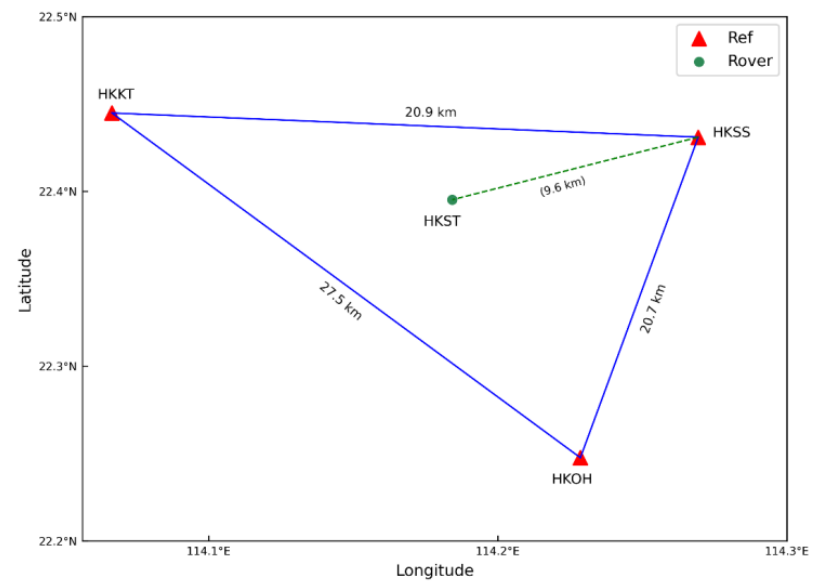
Figure 2. The distribution of experimental dataset 2 stations.